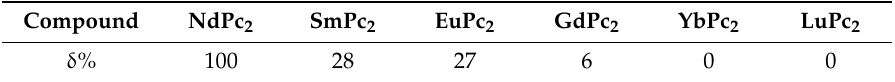
Table 2. Degradation degree, δ (%), of LnPc 2 during the reaction of LnPc 2 @TFA with triethylamine (TEA) in benzene; δ = [(A 0 − A 1 ) / A 0 ] × 100%, where A 0 and A 1 refer to the initial and final absorbance (recovered) of LnPc 2 , respectively (see Figure 4 and Figure S4 in SI).